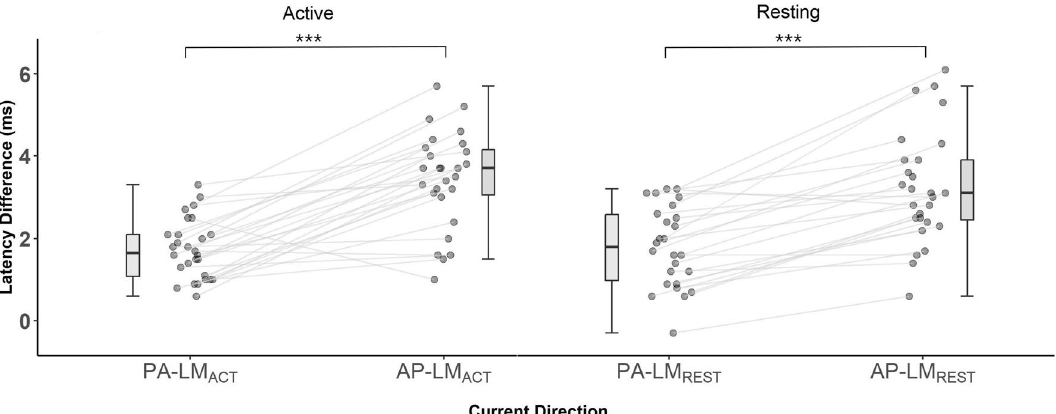
Figure 3. PA and AP Latency differences. Latency difference (ms), Individual PA and AP latencies subtract active LM latency; PA, posterior-anterior; AP, anterior–posterior; LM, latero-medial; Boxplots showing medians and IQR; *** p Tukey < 0.001.